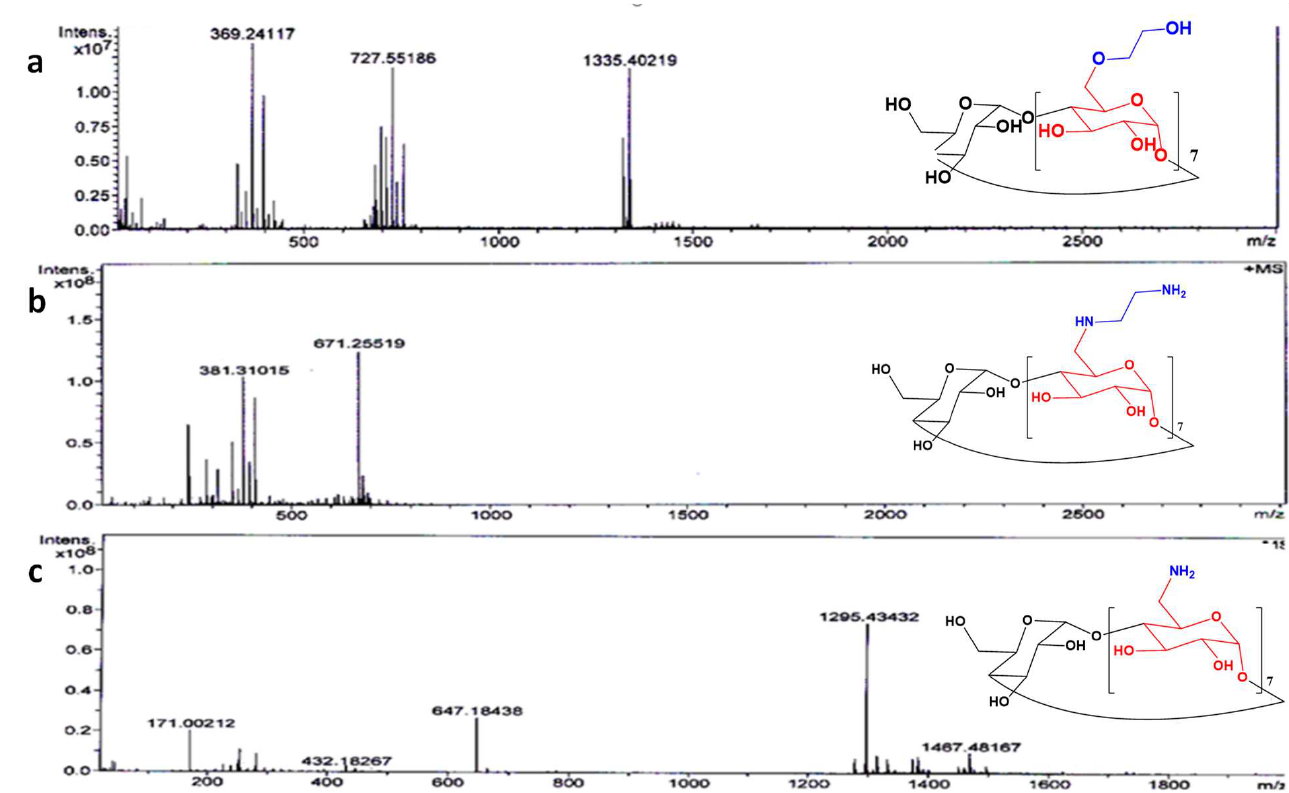
Figure 1. Mass spectra of ( a ) γ-CD-NHCH 2 CH 2 OH, ( b ) γ-CD-NHCH 2 CH 2 NH 2 , and ( c ) γ-CD-NH 2 on the positive mode.